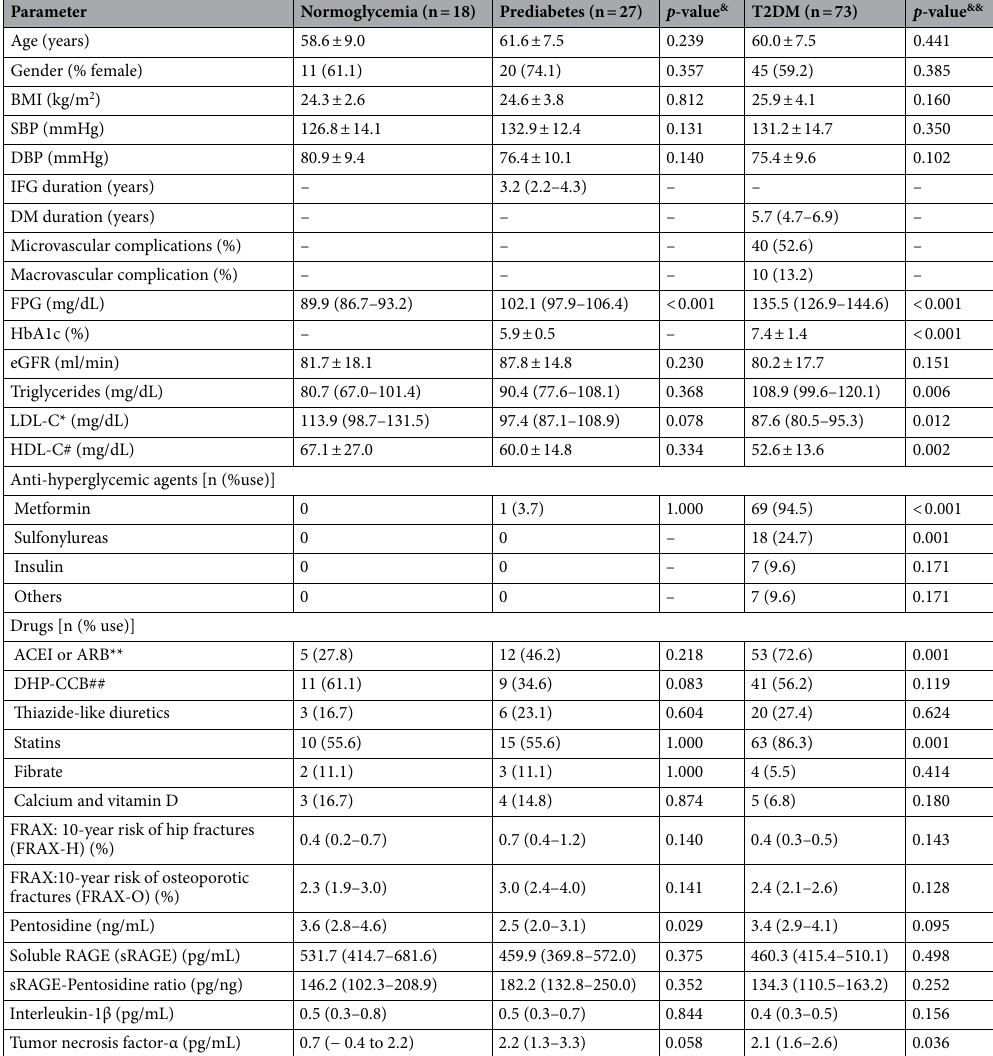
Table 1. Clinical characteristics of the study participants. & Comparison between groups with normoglycemia and prediabetes. && Comparison among groups with normoglycemia, prediabetes and T2DM. *LDL-C: low- density lipoprotein cholesterol; #HDL-C: high-density lipoprotein cholesterol; **ACEI: angiotensin-converting enzyme inhibitors; **ARB: angiotensin II receptor blockers; ## DHP-CCB: dihydropyridine calcium channel blockers.